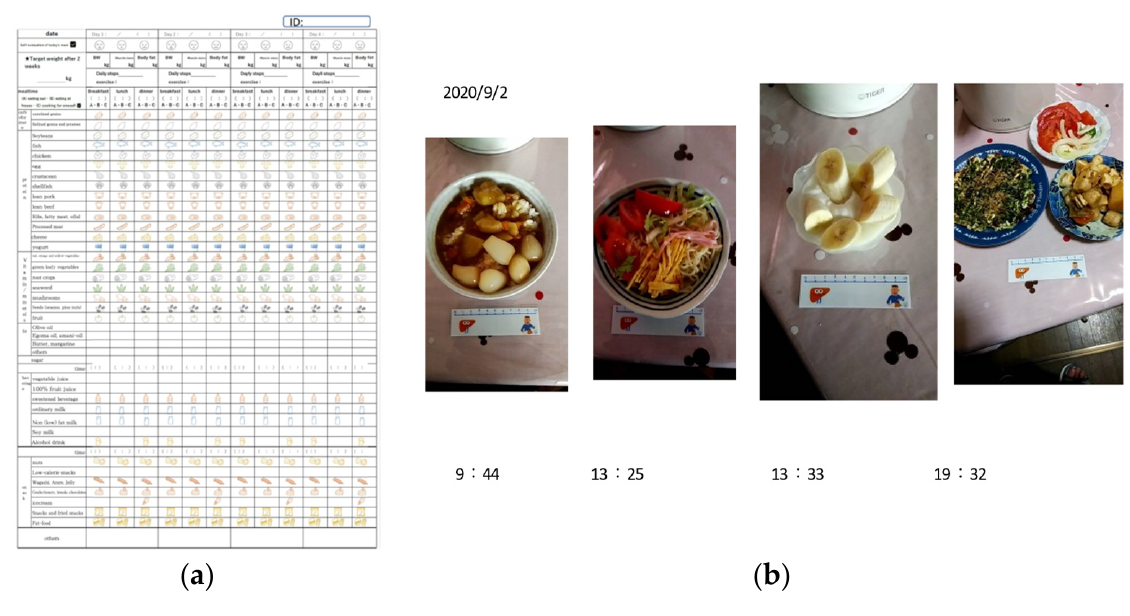
Figure 1. The food ingredients list frequency survey sheet and sample photographs of meals used in this study. ( a ) The food ingredients list frequency survey sheet; ( b ) Sample photographs of NAFLD patients in one day.